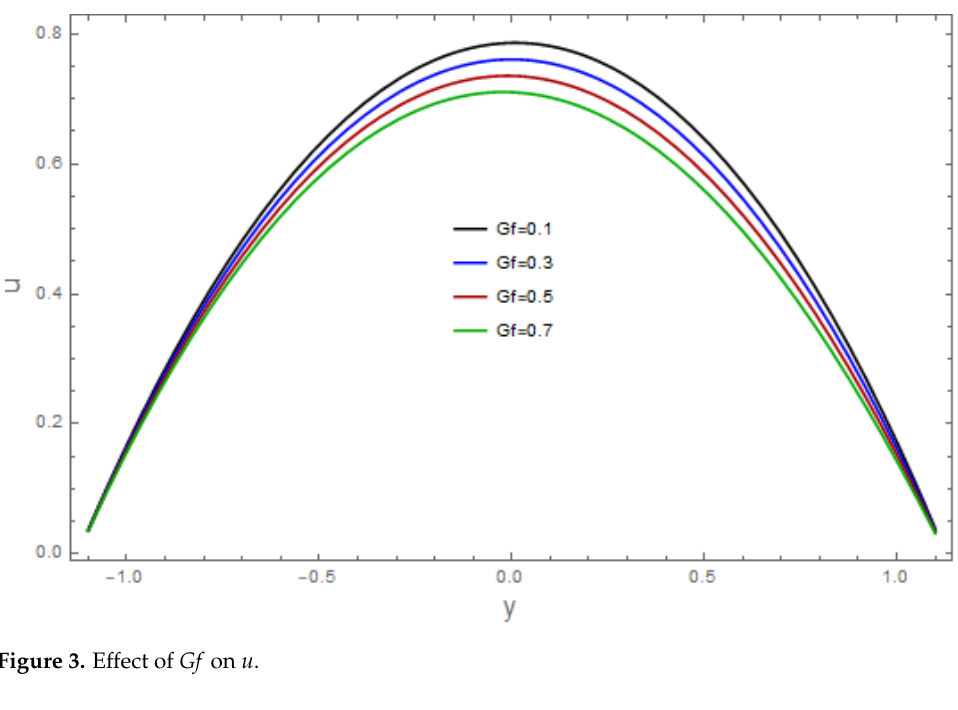
Figure 2. Effect of 𝐺𝑟 on 𝑢 .